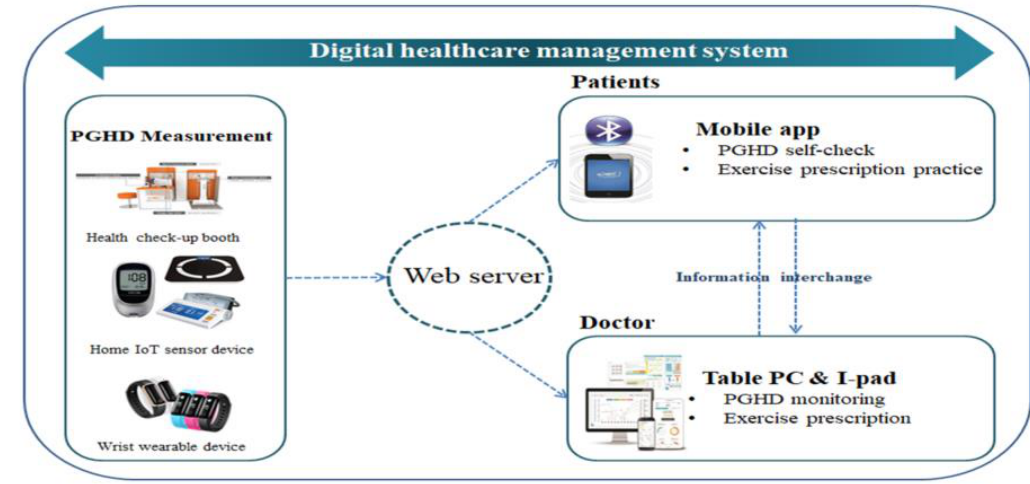
Figure 1. Digital healthcare management system.